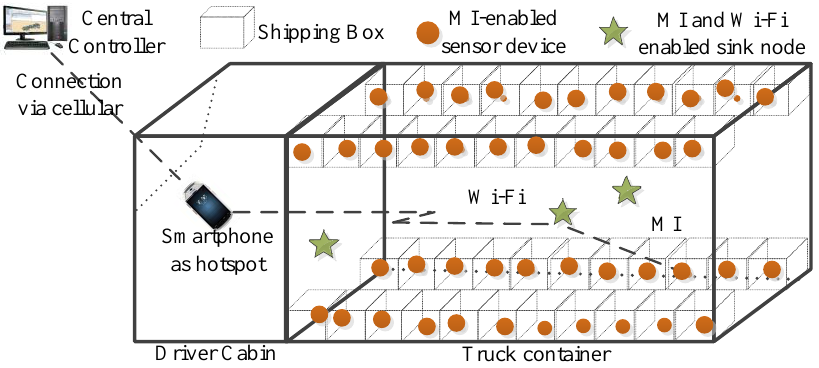
Figure 4. Quality sensing and communication for product boxes.